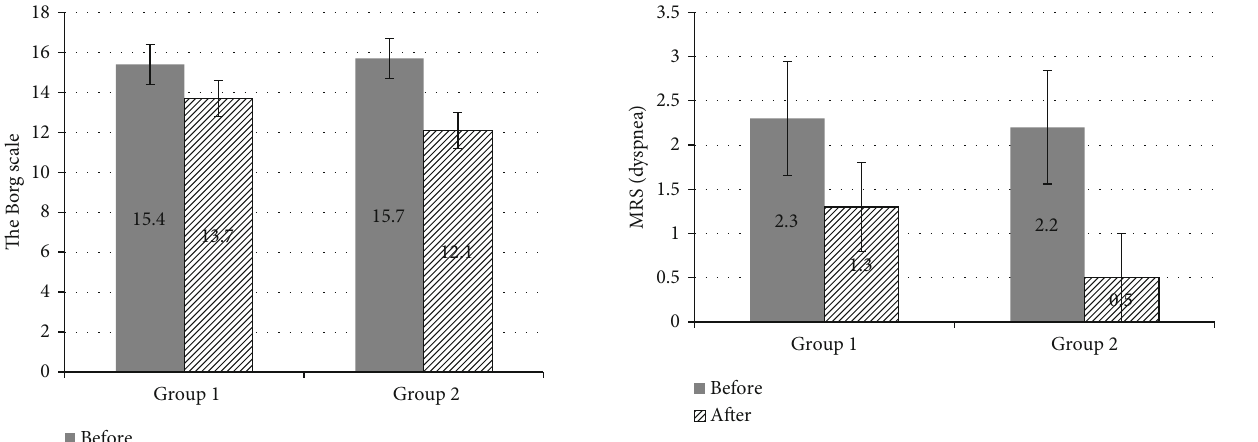
Figure 3: The mean scores before and after the treatment in groups 1 and 2 according to the MRS scale